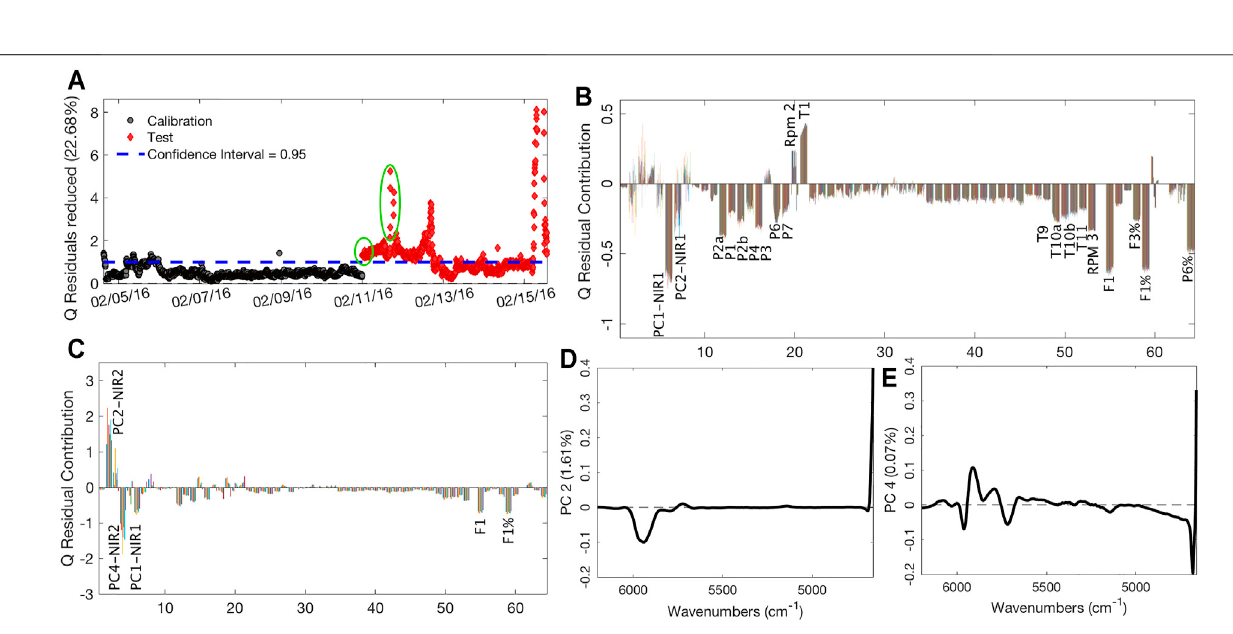
There are three different clusters of validation samples that are outside the con fi dence interval: a fi rst group corresponds to time observations taken 20 h before the production stop, and a second group corresponds to time observations taken 4 h after it, as described by the fi rst PC of NIR2 PCA. The third group is observed at the end of the monitored time. The T 2